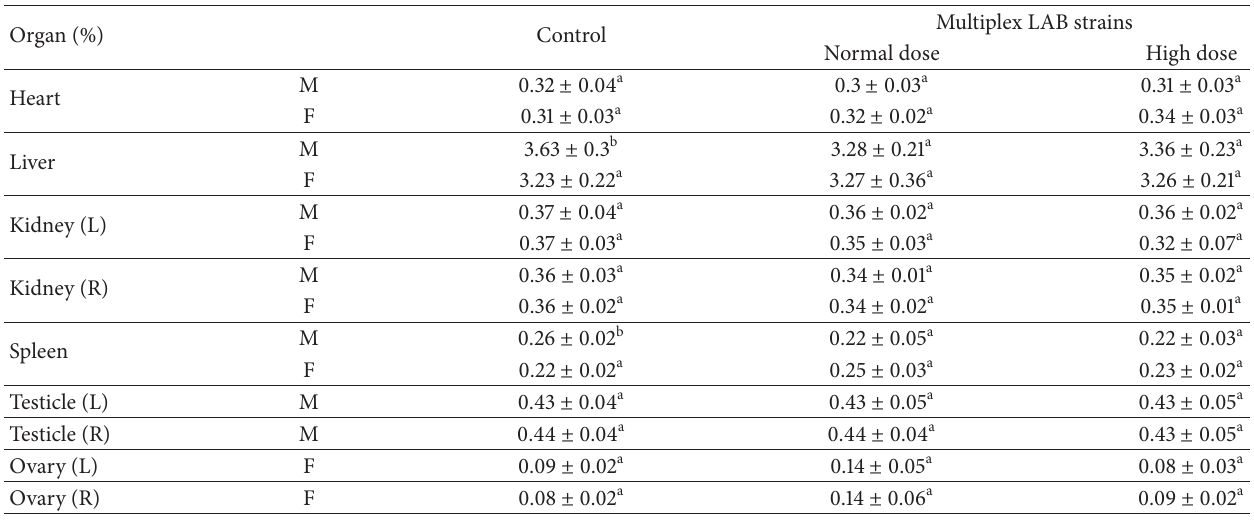
Table 4: Organ relative weights ( % ) § in rats that were treated orally with multiple LAB Strains for 28 days. Organ